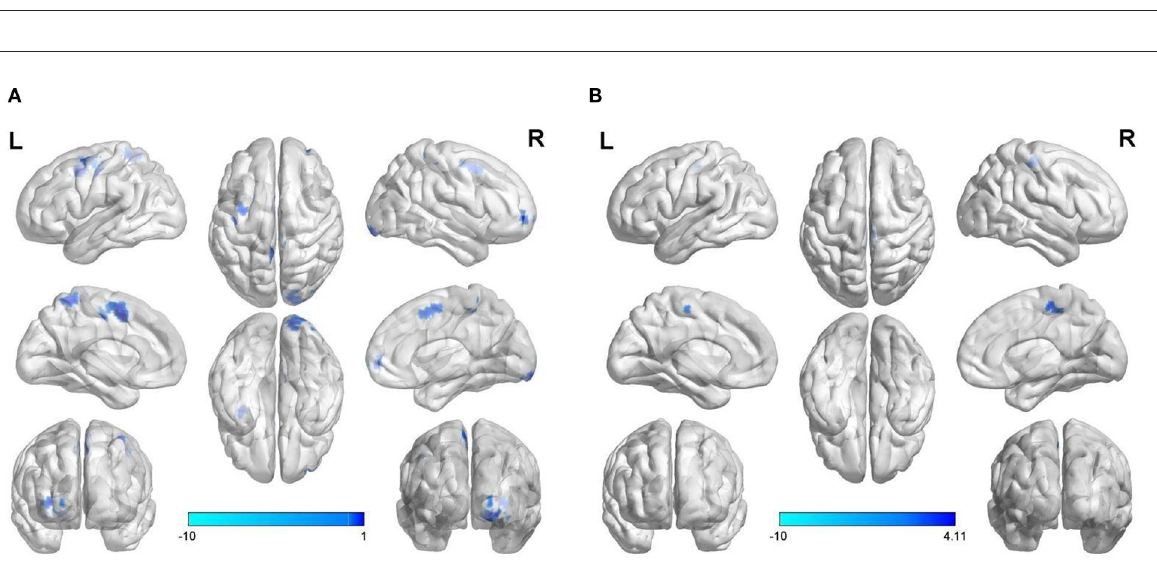
supplementary motor area (SMA.L), right paracentral lobule (PCL.R), and left precuneus (PCUN.L) in the vulnerable plaque group (Figure 3A and Table